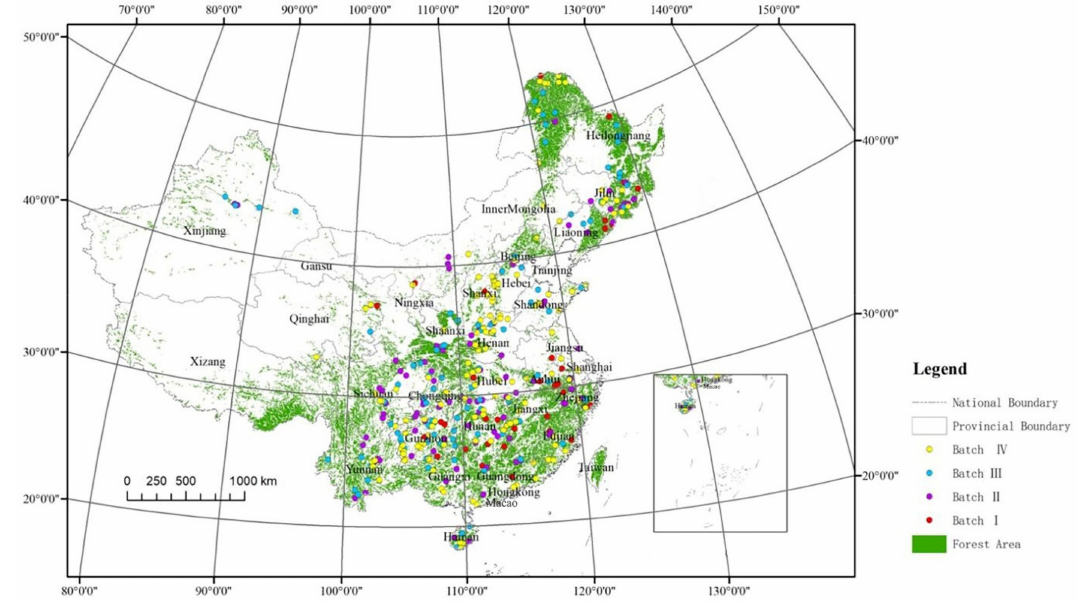
Figure 3. The study